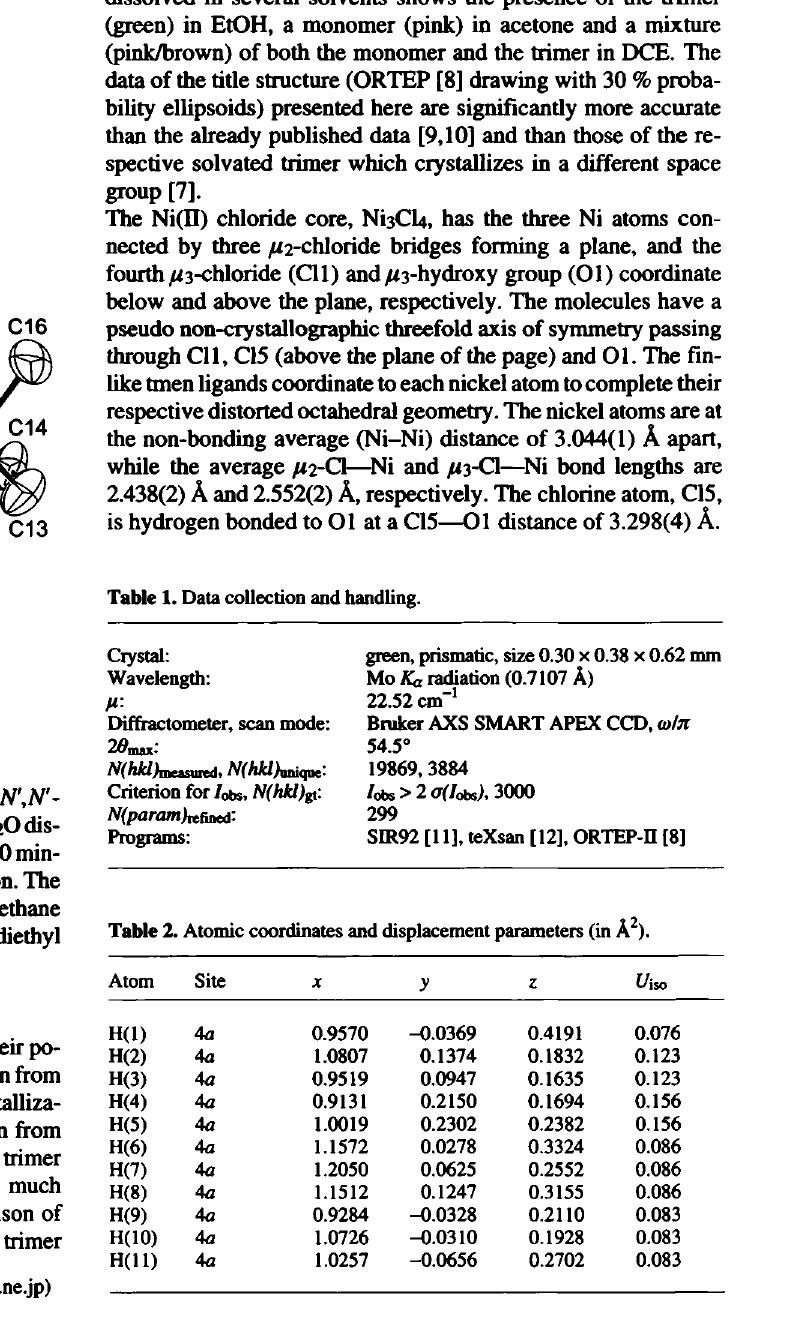
Table 2. Atomic coordinates and displacement parameters (in Ä 2